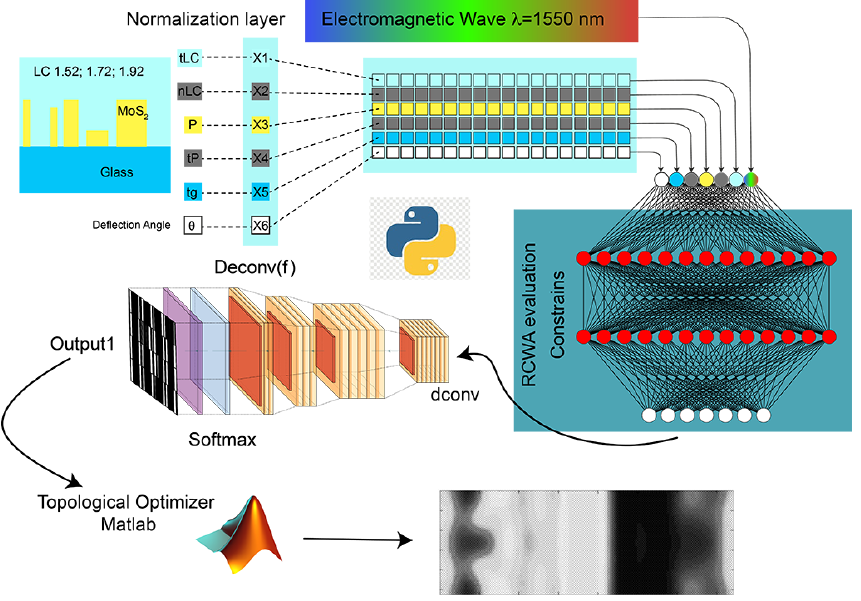
Figure 3. Working flow of the improved deep machine learning tool used to design the metasurfaces. The input data—such as material properties, number of elements, size—are stored and then processed in the neural network producing the input for the convolutional neural network that analyses the data and produces the preliminary MoS 2 arrangements as output. The optimizer tool is involved to carry out the final structure